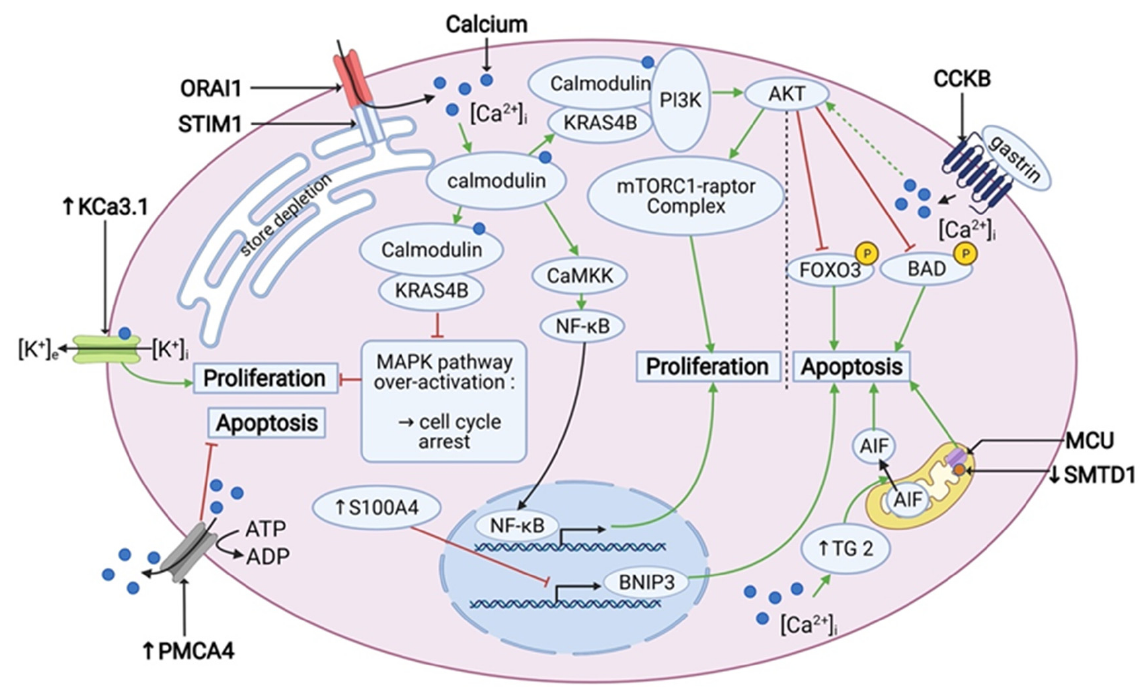
Figure 2. Calcium signaling is involved in the cell proliferation and apoptosis in PDAC. PDACs overexpress PMCA4 and TG2, which have an anti-apoptotic and pro-apoptotic effect, respectively. Also, SMTD1 and BNIP3, which have a pro-apoptotic effect, are under-expressed in PDAC. Under-expression of BNIP3 is driven by over-expression of S100A4. Gastrin has an anti-apoptotic effect via an inhibitory phosphorylation of FOXO3 and BAD by AKT. SOCE activates both the PI3K/AKT/mTOR pathway and the nuclear translocation of NF- κ B, which promotes proliferation. In addition, it prevents the overactivation of the MAPK pathway, which can lead to the cell cycle arrest. Also KCa3.1 channel is overexpressed and enhances proliferation. “ ↑ ” stands for overexpression and “ ↓ ” stands for under-expression. Created using BioRender.com source, accessed on 8 March 2021.